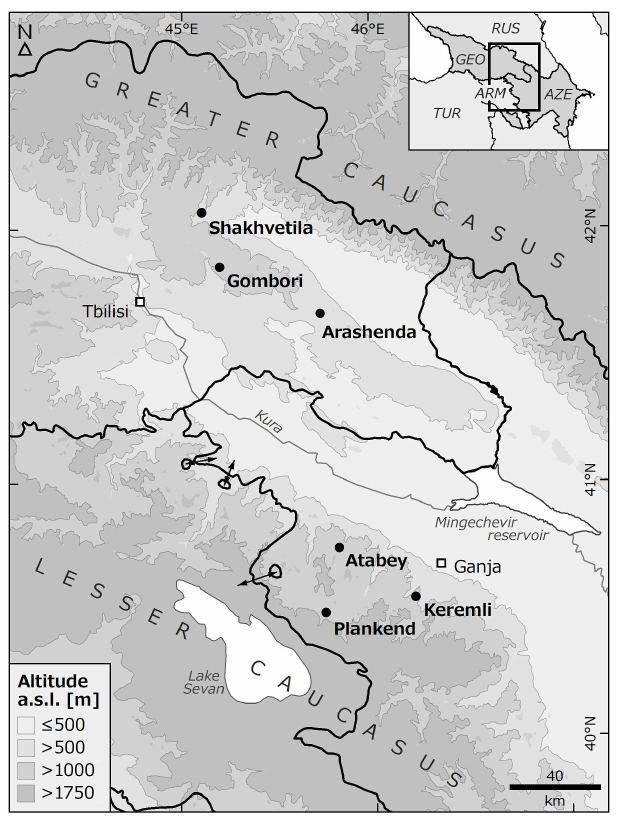
Fig. 2 . Location of case study villages (in bold) in Azerbaijan and Georgia. Sources: https://gadm.org/;